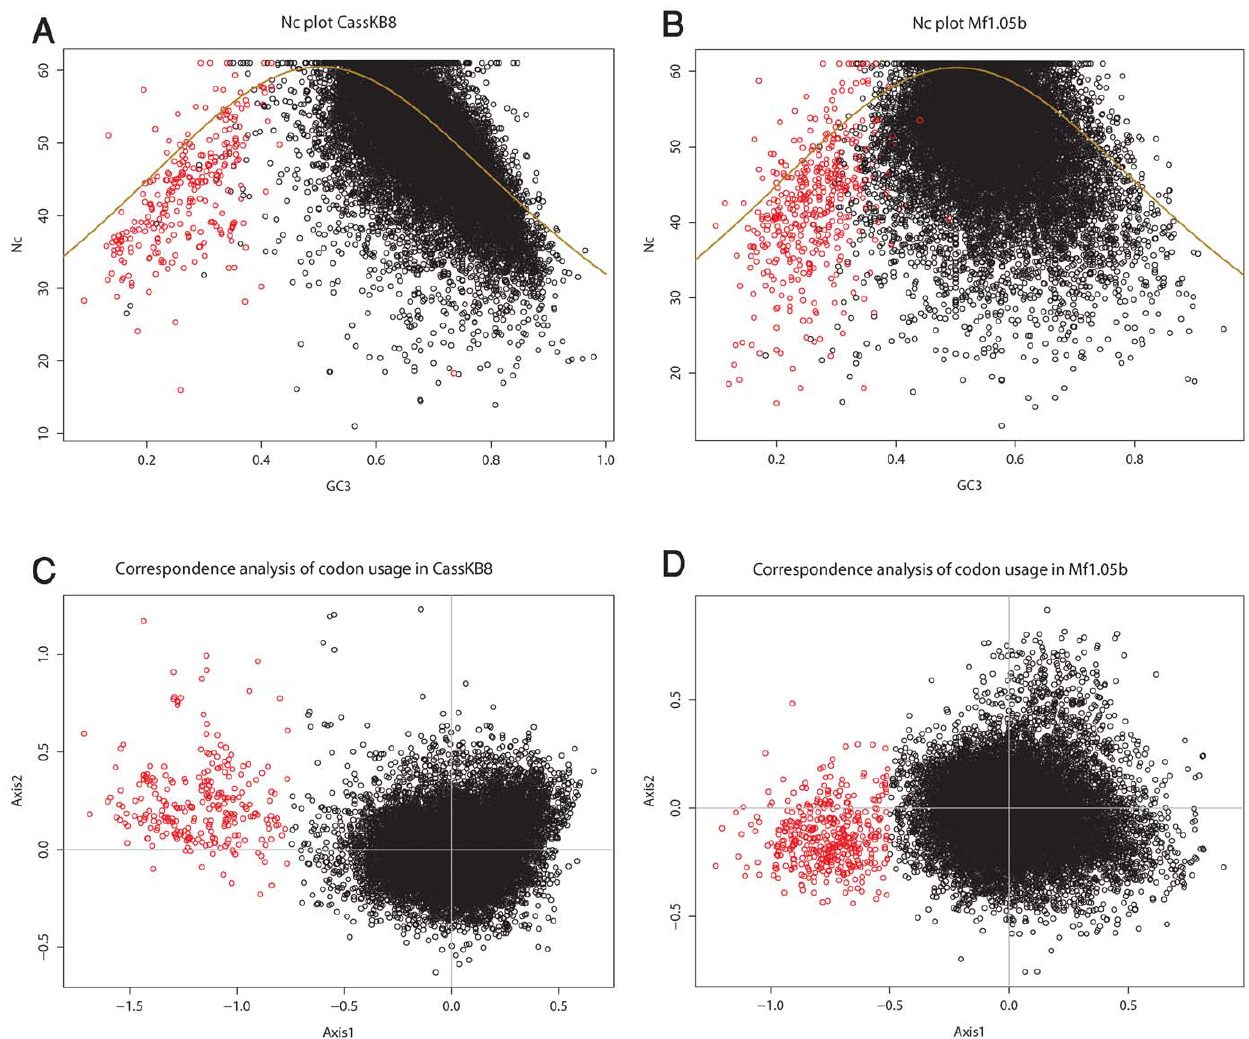
Figure 1. Nc and correspondence analysis of codon usage plots. (A, B) Plots of the effective number of codons (Nc) plotted versus third codon position GC content (GC3) in CassKB8 and Mf1.5b respectively. The red points are the same genes as in C and D, respectively. The yellow line represents the neutral expectation for Nc. (C, D) Correspondence analysis of codon usage. The genes separated from the main cloud are marked red.